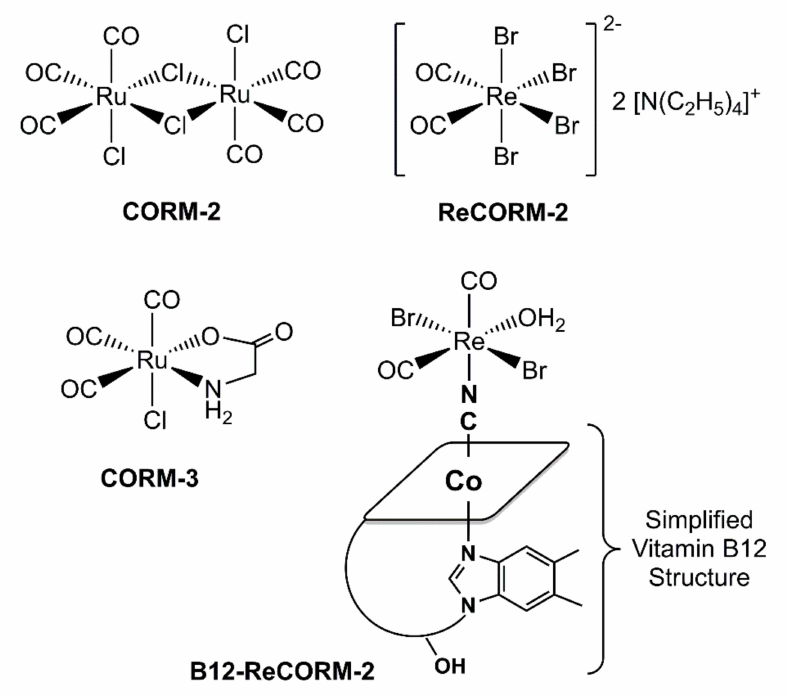
Figure 1. Chemical structures of CORM-2, CORM-3, and ReCORM-2 and B 12 -ReCORM-2 (used in this